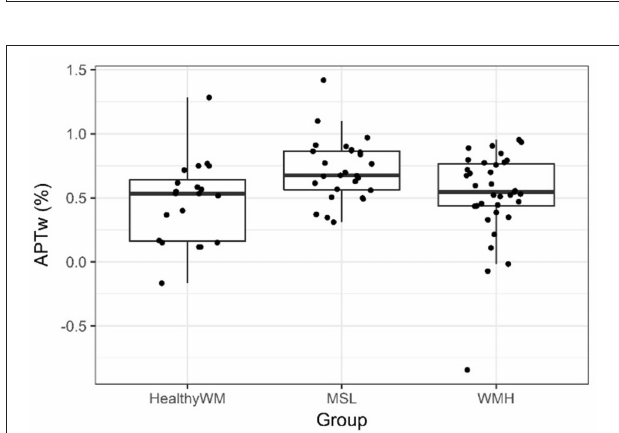
FIGURE 7 | Boxplots with jittered individual data points depicting mean APTw signal intensity values of healthy white matter (HealthyWM) ( n = 20), MS lesions (MSL) ( n = 27), and white matter hyperintensities of presumed vascular origin (WMH) ( n = 35) that were averaged for each patient/proband. The line in the box shows the median, the lower and upper hinges correspond to the first and third quartiles, the upper/lower whisker extends from the hinge to the largest/smallest value no further than 1.5 * IQR from the